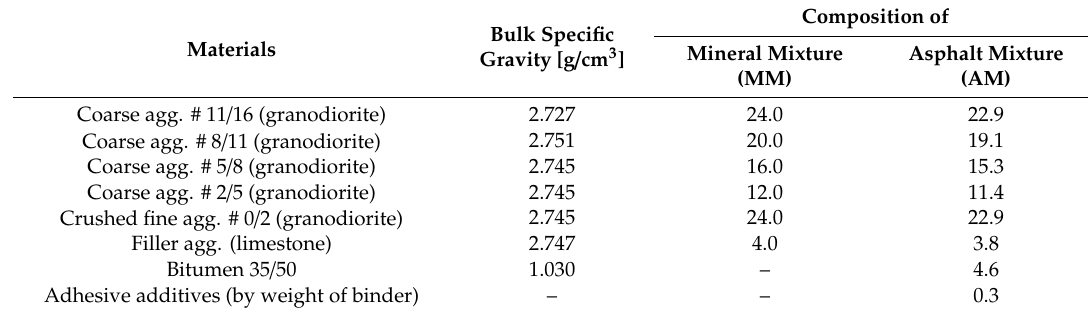
Figure 2. Grading of the mineral mixture in the AC 16 W 35 / 50 asphalt concrete. Table 2. Components of the AC 16 W 35 / 50 binder course mixture.